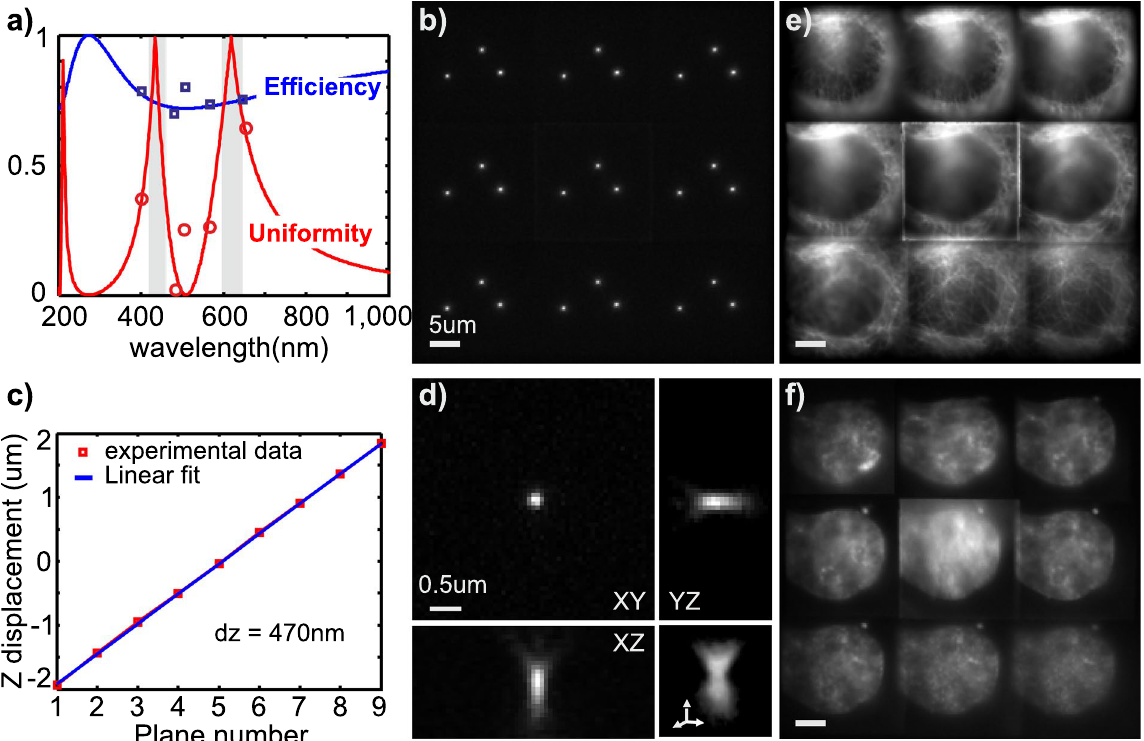
Figure 4. Optical characterization and validation of the fabricated 0.84 × π grating. ( a ) Simulations of the efficiency and uniformity of the diffraction through the grating as function of the wavelength. Overlaid are the measured values of the efficiency (blue squares) and uniformities (red circles). ( b ) Maximum intensity projection of a Z stack of fluorescent 200 nm diameter beads when imaged using multifocus microscope. ( c ) Validation of the plane spacing as measured by the beads. The spacing was found to be 470 nm for an emission centered at 620 nm in good agreement with the design value. ( d ) Zoom in on a point spread function of on the imaging planes, showing a diffraction limited PSF with no additional aberrations due to the grating motif. ( e ) Multifocus image of tubulin fibers in U2OS cells labeled with TMR molecules. ( f ) Multifocus image of the nuclear DNA labeled with Hoechst. The two images are taken with the same multifocus multicolor